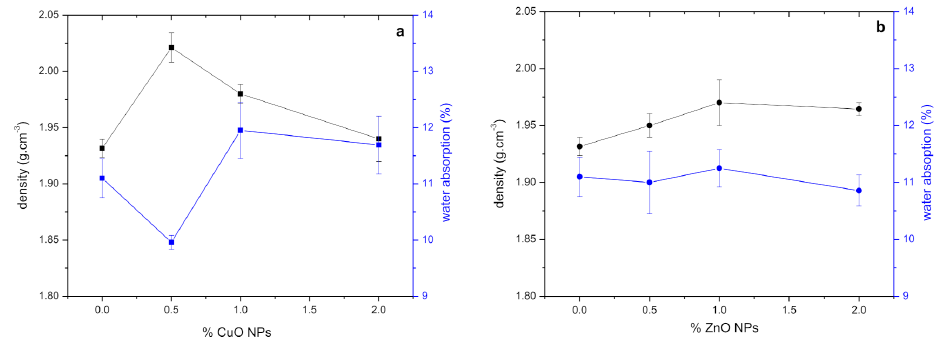
Figure 7. Density and water absorption of GWC IPs with different amounts of ( a ) CuO and ( b ) ZnO